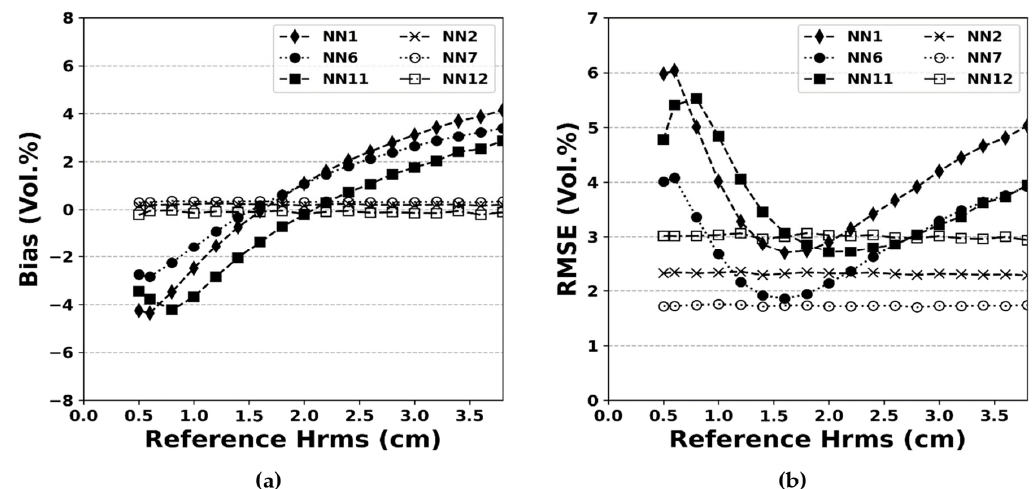
Figure 4. Evolution of bias and RMSE on the SSM estimations from synthetic C-band data as a function of reference Hrms. The NNs built are without the use of Hrms in the input (NN1 without a priori information on SSM, NN6 with a priori information on SSM in dry to slightly wet soil conditions, NN11 with a priori information on SSM in very wet soil conditions) and with the use of reference Hrms in input (NN2 without a priori information on SSM, NN7 with a priori information on SSM in dry to slightly wet soil conditions, NN12 with a priori information on SSM in very wet soil conditions). ( a ) Bias (estimated SSM − reference SSM); ( b ) RMSE on SSM.